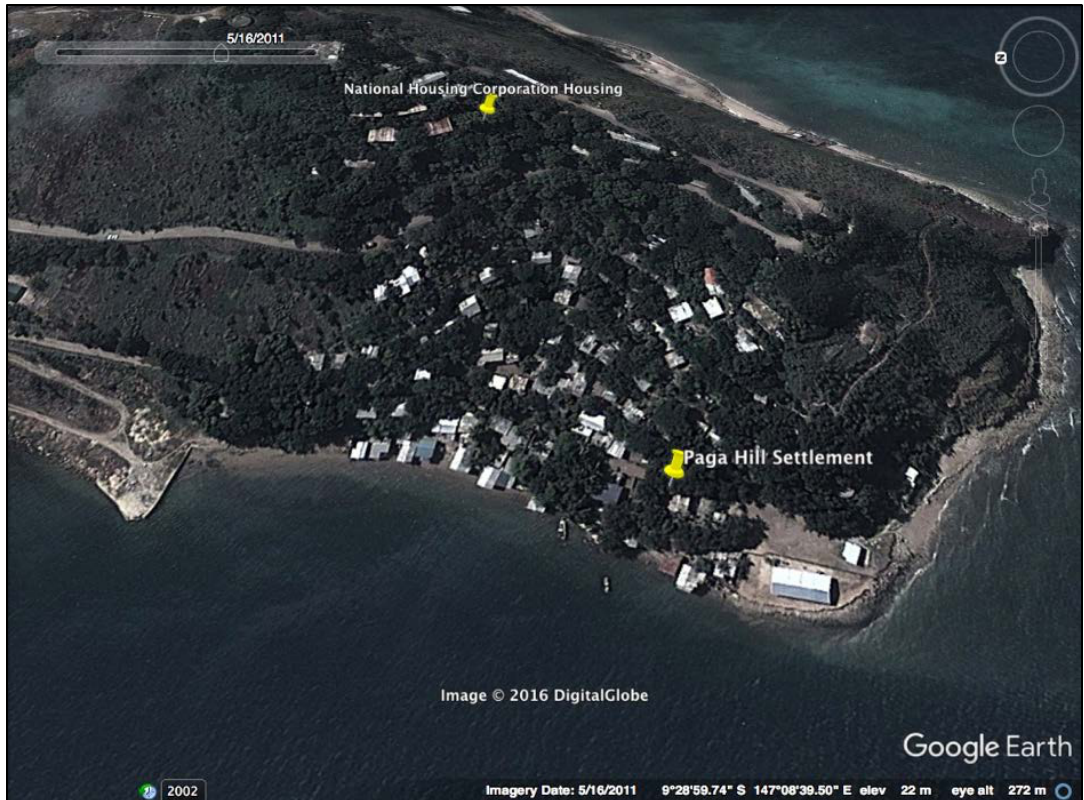
Figure 4: Paga Hill, 16 May 2011 Source: Google